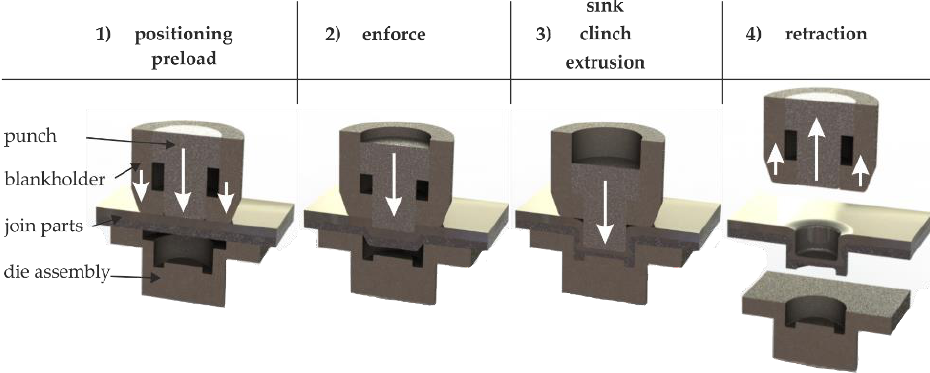
Figure 2. The process cycle of creating a clinched joint.